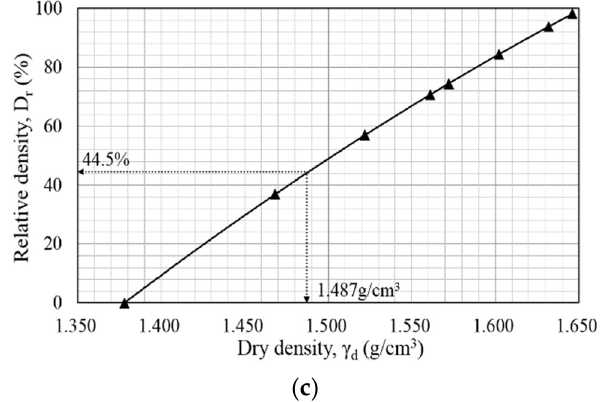
Figure 5. Mechanical properties of the Jumunjin standard sand: ( a ) dry density of the Jumunjin standard sand, relative to the drop height; ( b ) internal friction angle, relative to the dry density; and ( c ) relative density, relative to the dry density.